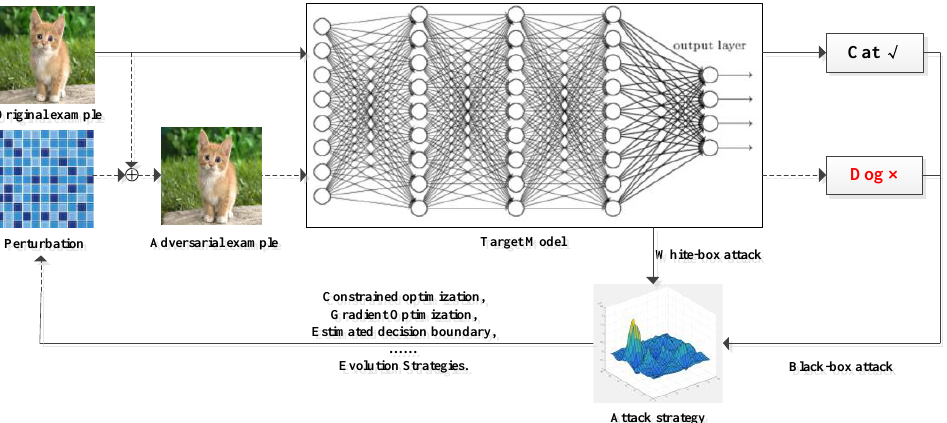
Figure 2. Adversarial example generation and adversarial attack process.